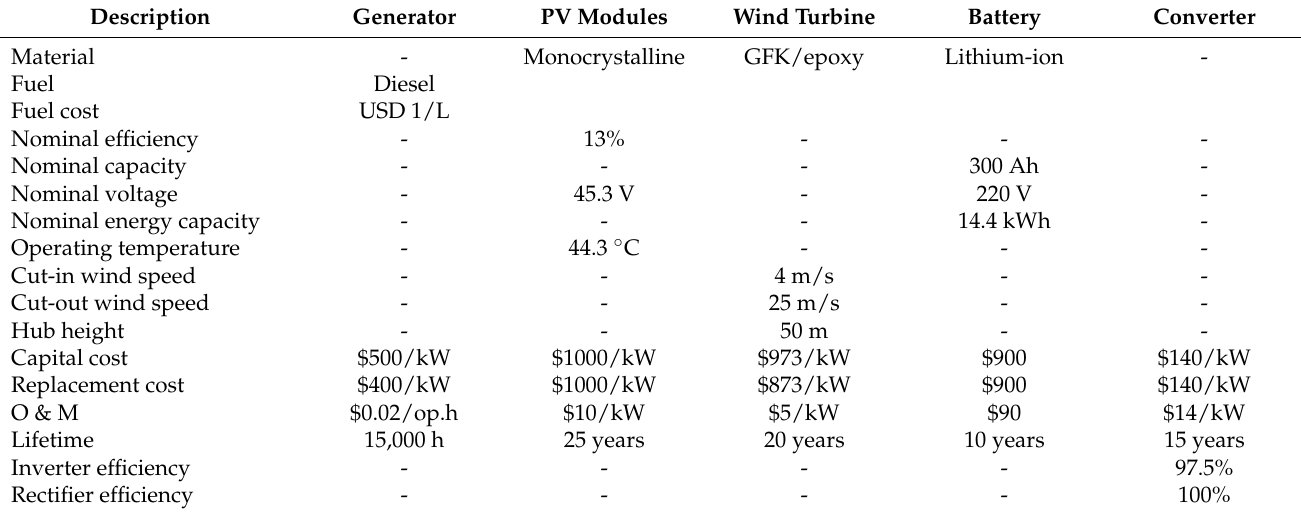
Table 3. Technical specifications and cost of the components for the proposed hybrid system